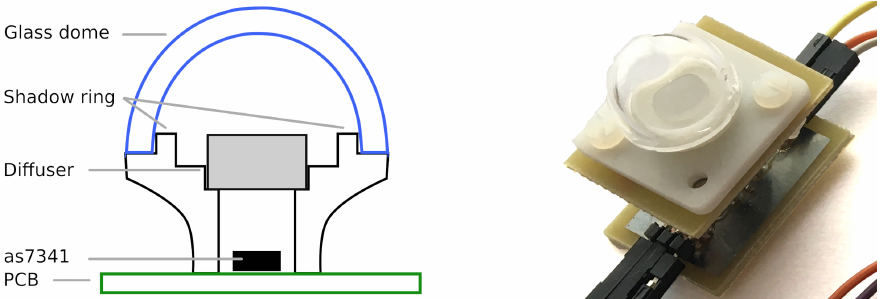
Figure 2. For all tests, the ams AS7341 is put into a housing formed to achieve cosine correction for incoming light. As the optical filters are integrated in the AS7341, there is no need for additional parts in the housing other than a diffuser and in our case an optional glass